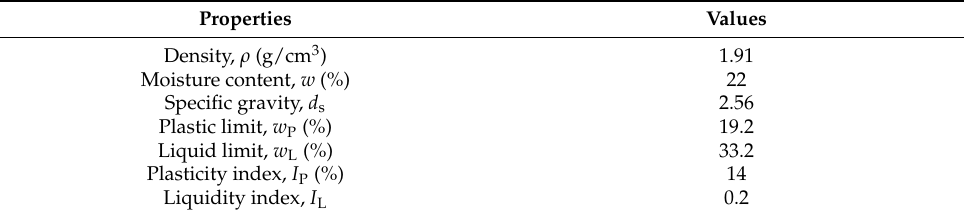
Figure 1. Root – soil composite sample. ( a ) root soil drill; ( b ) undisturbed root – soil composite. Figure 1. Root–soil composite sample. ( a ) root soil drill; ( b ) undisturbed root–soil composite. According to the geotechnical test method standard (GBT 50123-2019), the physical and mechanical indicators of the undisturbed root – soil composite are shown in Table 1. Table 1. Basic physical and mechanical properties of soil [18]. Table 1. Basic physical and mechanical properties of soil